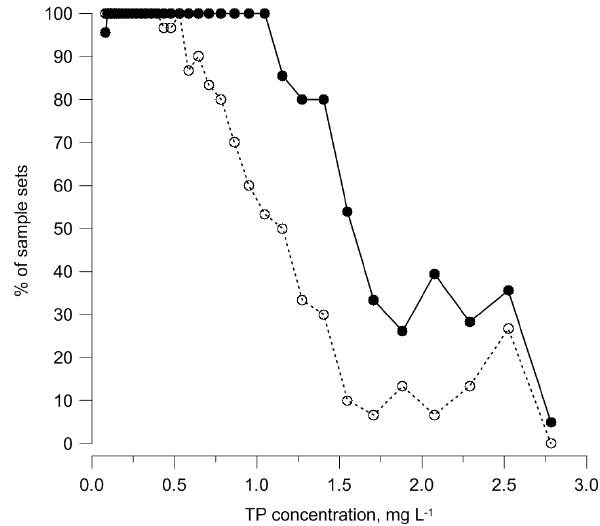
Fig. 3. Percentage coverage of the TP concentration range by the sample sets using the 24/7 sampling solution (closed symbols) and daily sampling solution (open symbols). The 24/7 solution is ap- proximately twice as likely to sample higher TP concentrations, with for example, 100% of the 24/7 sample sets containing sam- ples in the 1mgl − 1 range while only 50% of the daily sample sets contain values in the same